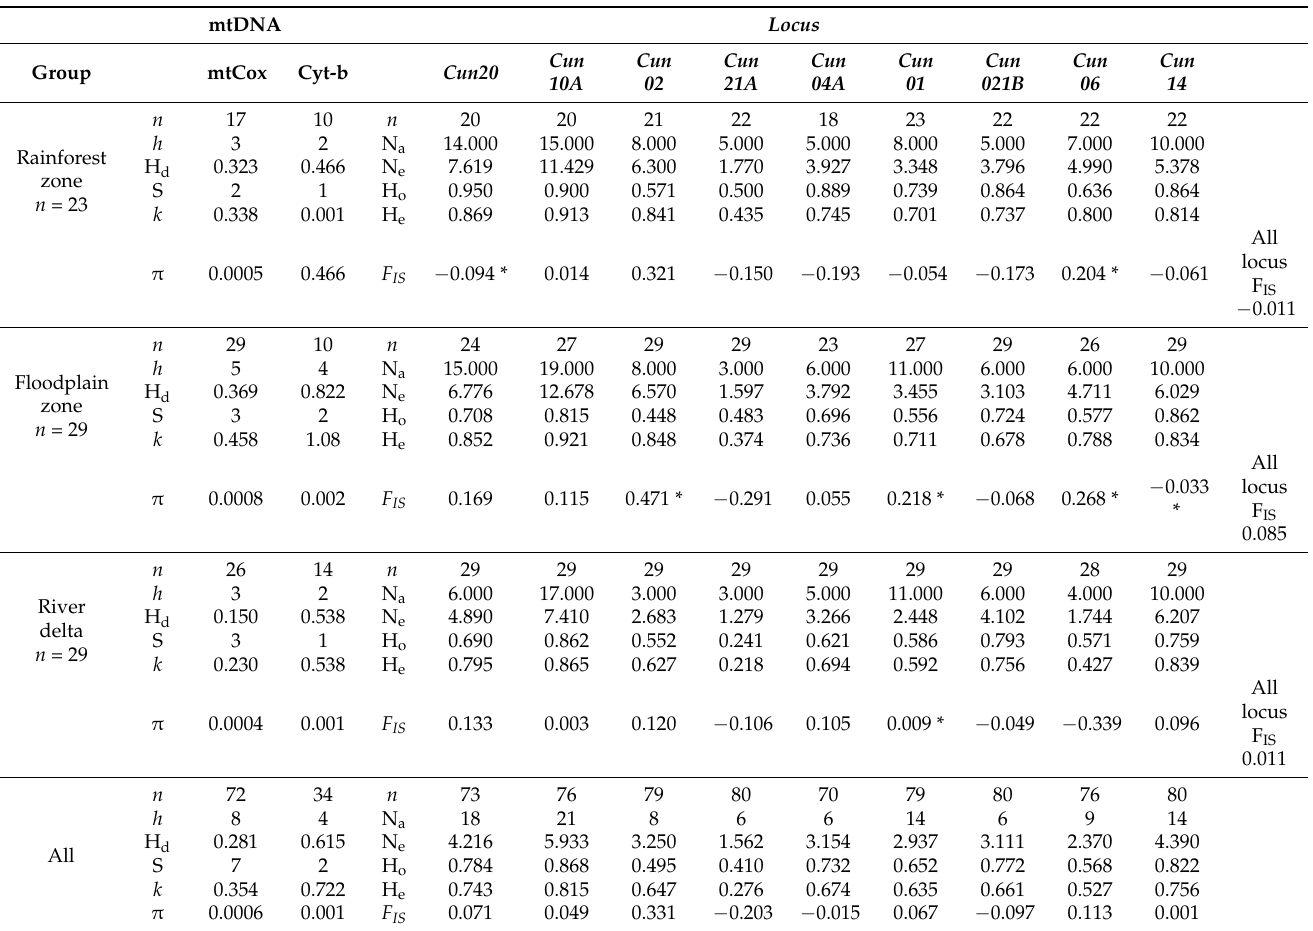
Table 1. Genetic diversity estimations of mtDNA for each zone of the common snook ( Centropomus undecimalis ): n = number of sequences; h = number of haplotypes; H d = haplotypic diversity; S = number of variable sites; k = average pairwise nucleotide differences; π = nucleotide diversity. Summary statistics for nine polymorphic microsatellite loci: n = number of individuals with amplification; N a = number of alleles per locus; N e = effective number of alleles per locus; H O = observed heterozygosity; H e = expected heterozygosity; F IS = fixation index given for each locus. Values with the asterisk represent significant deviations from Hardy–Weinberg